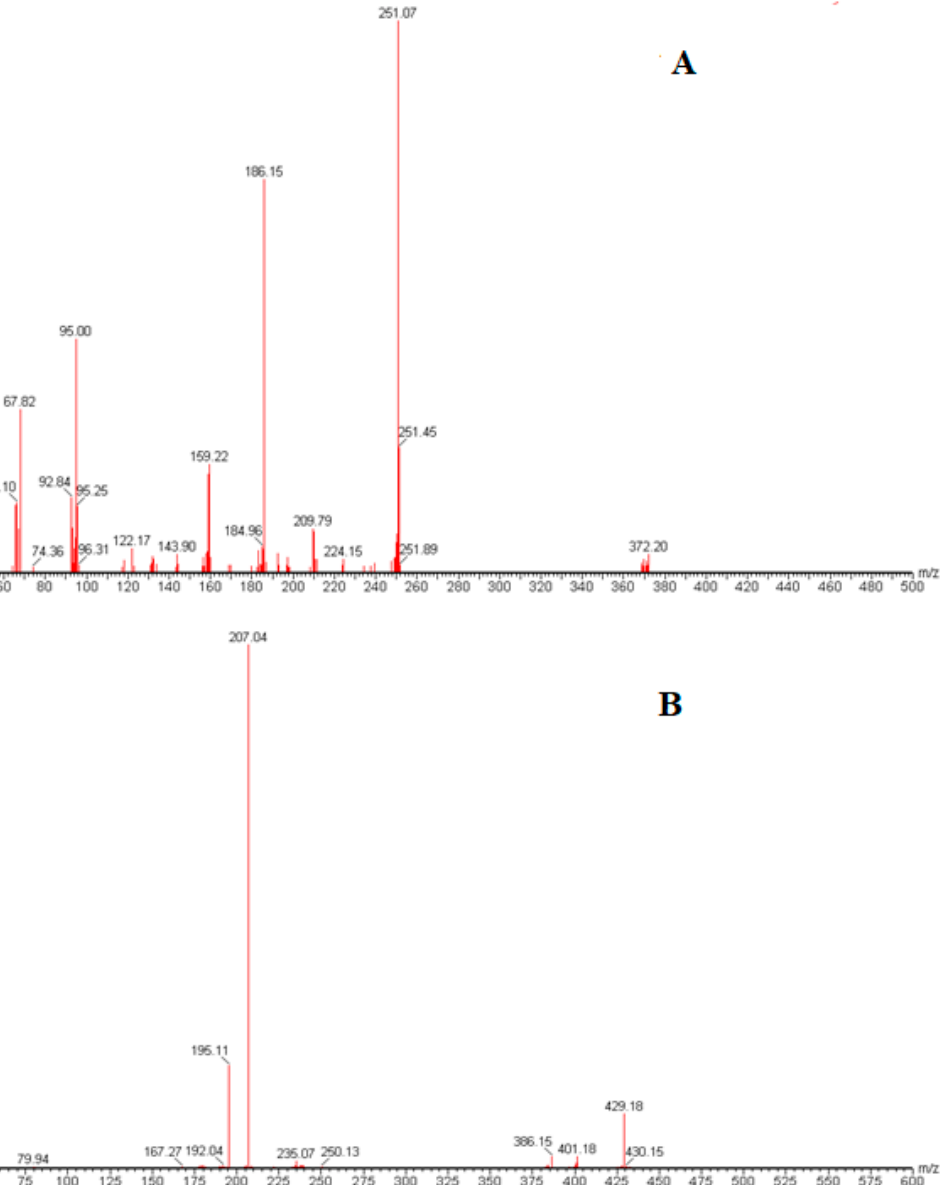
Figure 2. Positive ESI product ion mass spectra of baricitinib ( A ) and irbersartan ( B ) obtained from collisional activated dissociation of the precursor ion m / z 372.20 and 429.18, respectively. Different types of column were tested and Acquity UPLC HILIC BEH 1.7 µm 2.1 × 50 mm